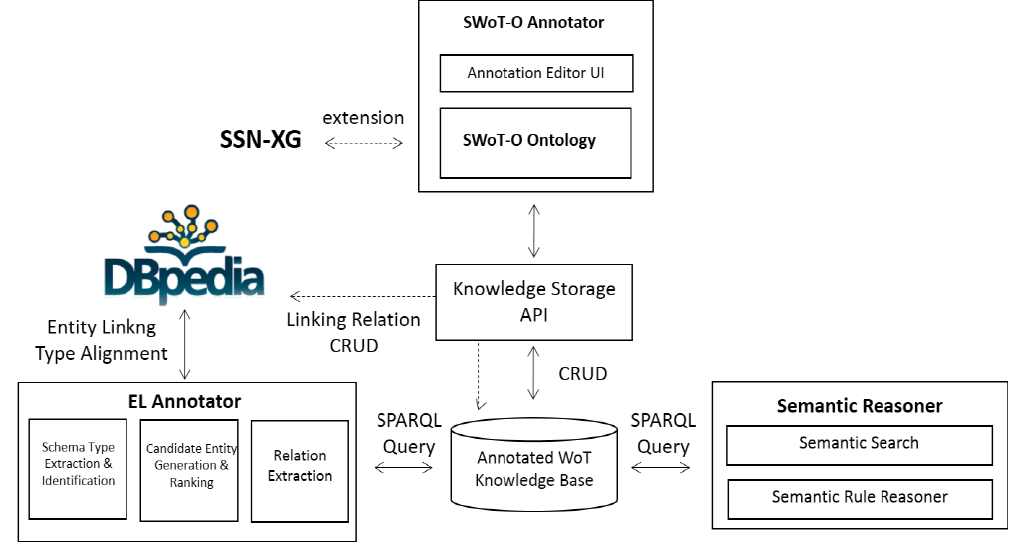
Figure 1. The SWoT system overview.